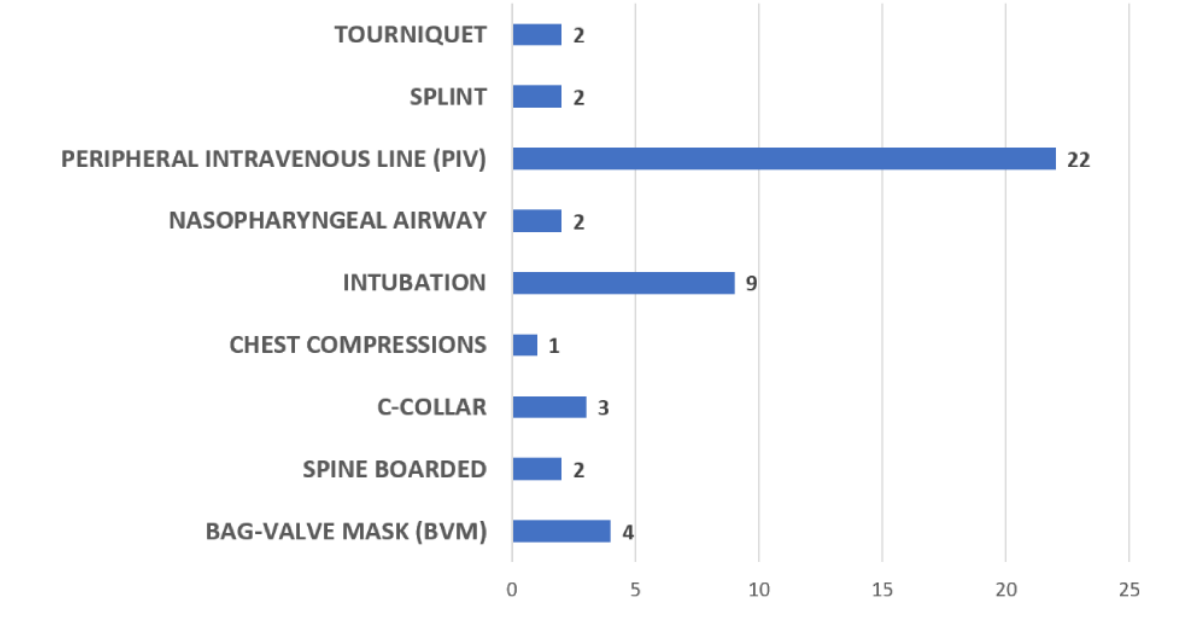
Figure 3. Frequency of each mechanism of injury in the trauma